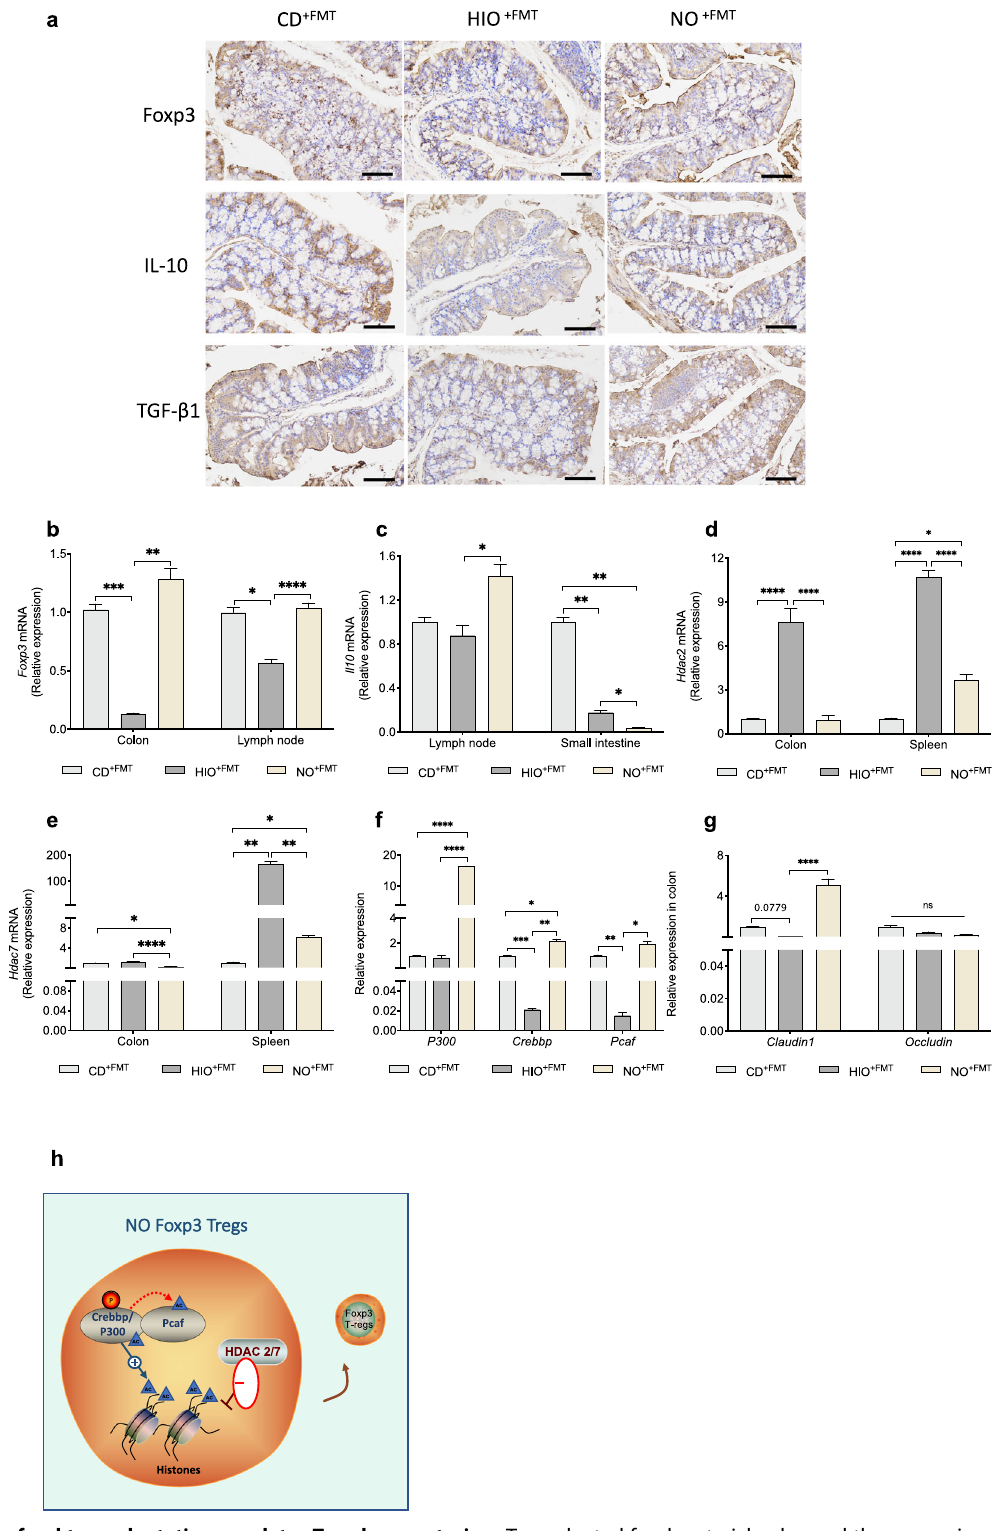
Fig. 6 NO mice fecal transplantation regulates Treg homeostasis. a Transplanted fecal material enhanced the expression of the colon Treg- related immune factors Foxp3 and IL-10 and TGF- β 1, as measured by immunohistochemistry (400×), length of the scale bar is 200 μ m. b , c Relative mRNA expression levels of Foxp3 and Il10 measured in the colon, lymph nodes, or small intestine. d , e Relative mRNA expression levels of Hdacs , including Hdac2 and Hdac7 measured in the colon and spleen. f Expression of histone acetyltransferases, including P300 , Crebbp and Pcaf , in the colon. g Claudin1 and Occludin mRNA expression in the colon. h Figure abstract of the regulatory mechanism of acetylated Foxp3. Two-way ANOVA was used to analyze the signi fi cance of differences in the relative mRNA expression. Data are presented as means ± SEM ( n = 3). * p < 0.05, ** p < 0.01, *** p < 0.001, **** p <